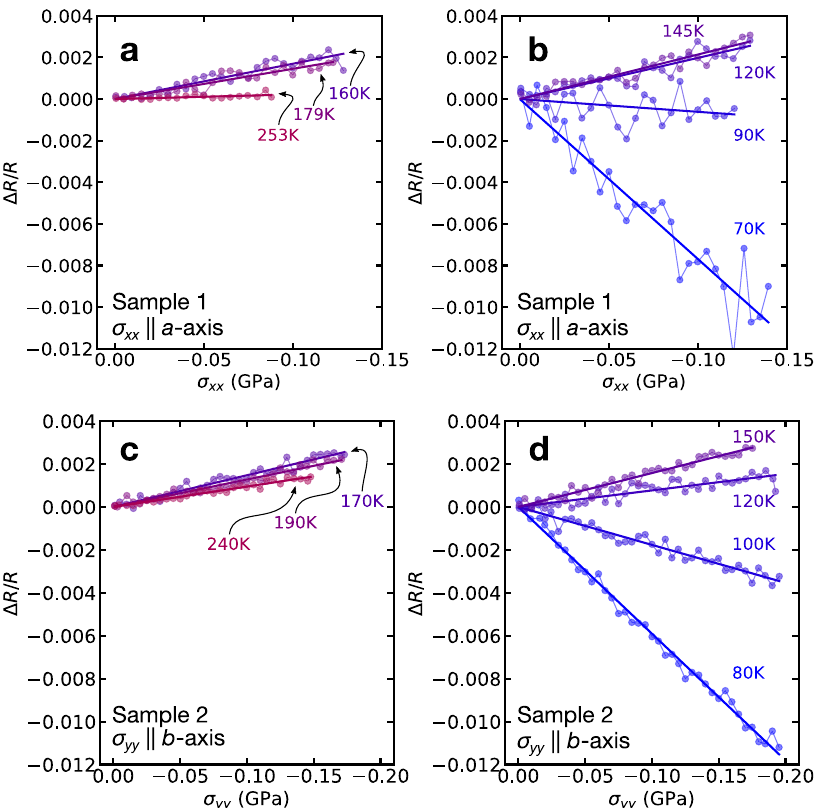
Fig. 2 Stress sweep measurements of the normalized electrical resistance. a Change of resistance Δ R / Rvs . uniaxial stress σ xx for different temperatures above T = 150 K. The resistance R was measured and σ xx was applied along the a -axis. Solid lines are the results of linear fi ts. b Same as ( a ), with T ≤ 150 K. c , d Same as ( a , b ) with R and σ yy parallel to the b